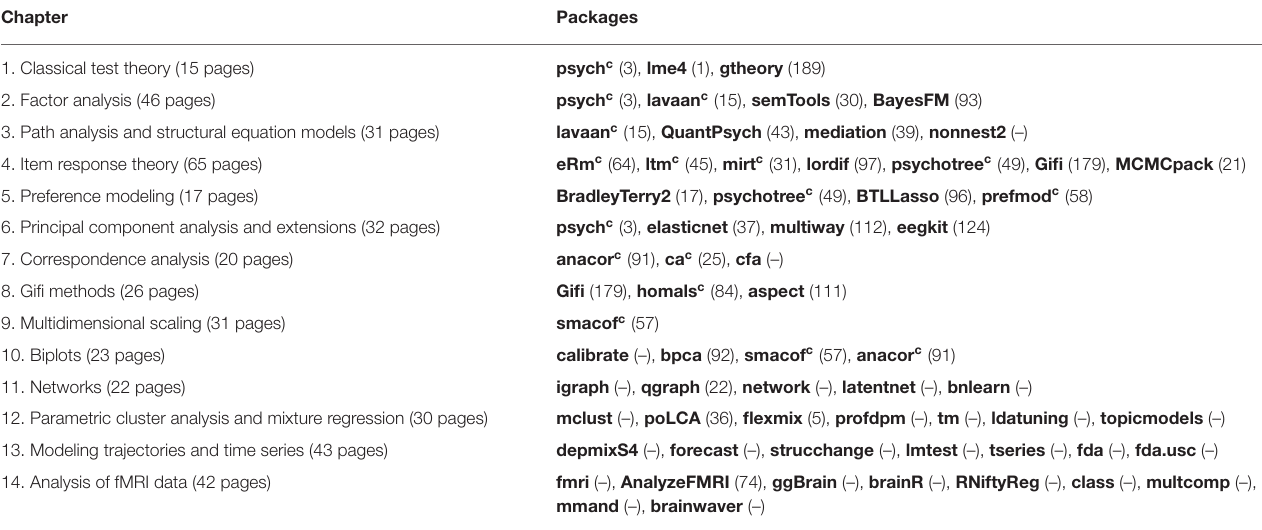
TABLE 1 | Table of contents and R packages used in Mair